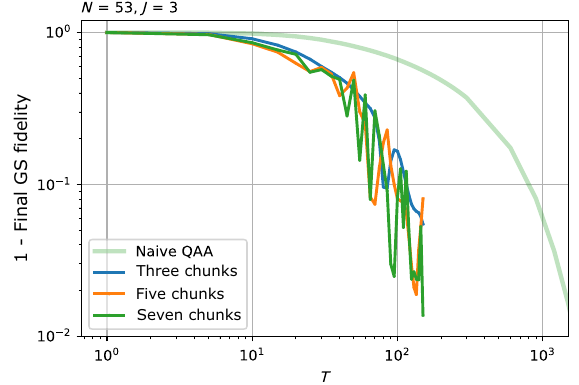
FIG. 2. Black-box VQAA results for 53 qubits and the ZZXZ model for the case of a crossed phase transition ( J = 3). Results for three, five, and seven chunks, respectively, are shown. More chunks do not improve the results as for one avoided level cross- ing an optimized path can already be approximated with very few chunks. The quantum-classical feedback loop converges to opti- mized adiabatic paths that prepare the ground state with > 90% fidelity for T (cid:2) 100. In order to achieve this ground-state fidelity with (nonoptimized) naive QAA, an evolution time about 10 times larger would be